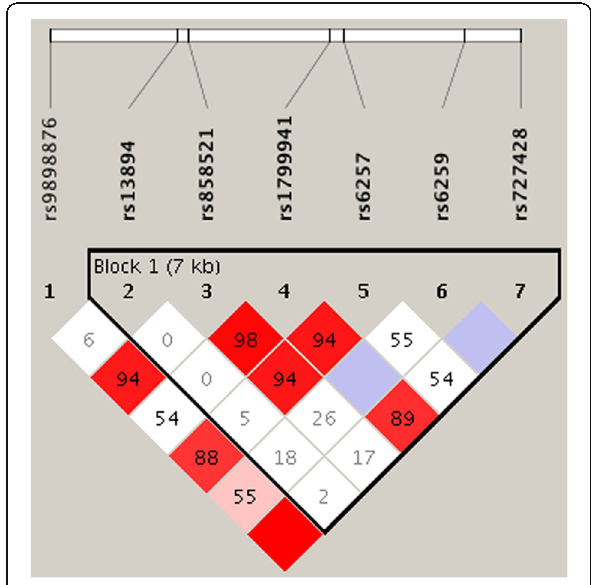
Fig. 1 Haploview graph of SHBG SNPs analyzed. The positions of the seven SNPs used (Build 37.3) are indicated along with the basic gene structure, and displayed above the Haploview output. The relative LD between specific pair of SHBG SNPs is indicated by the color scheme, which represents the LD relationships. This is based on D ’ values (normalized linkage disequilibrium measure or D) multiplied by 100; D ’ is calculated as D divided by the theoretical maximum for the observed allele frequencies. Values approaching zero indicate absence of LD, and those approaching 100 indicate complete LD. The square colored red represent varying degrees of LD<1 and LOD (logarithm of odds)>2 scores; darker shades indicating stronger